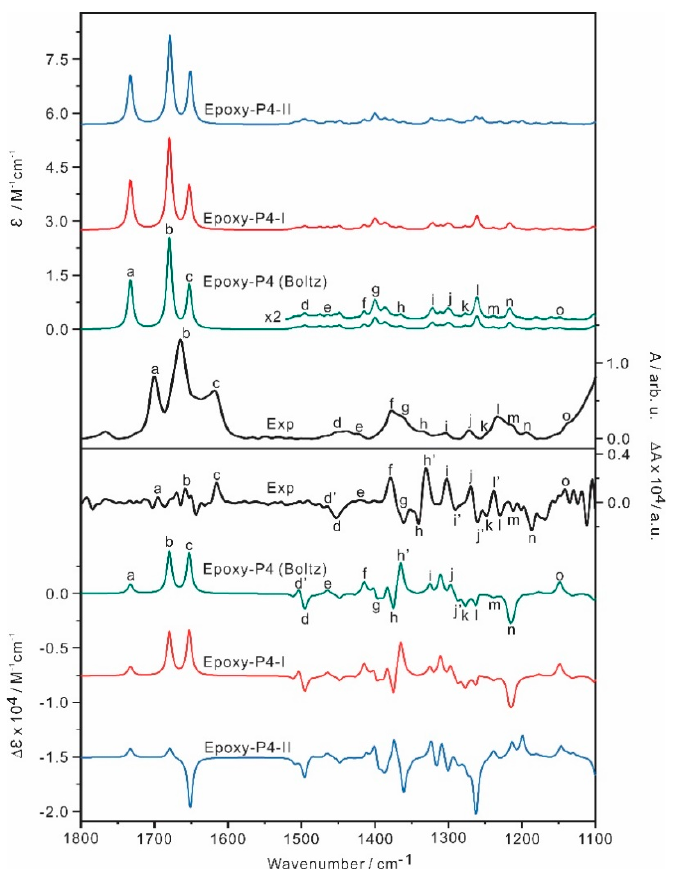
Figure 5. Simulated IR and VCD spectra of the two most stable Epoxy − P4 conformers, Epoxy − P4 − I and − II, and the related Boltzmann averaged IR and VCD spectra at the B3LYP − D3BJ/def2 − TZVPD/PCM(DMSO) level of theory at 298 K. The experimental units are on the right side. The main IR and VCD band features are labelled as ‘a’ to ‘o’ to aid the comparison.